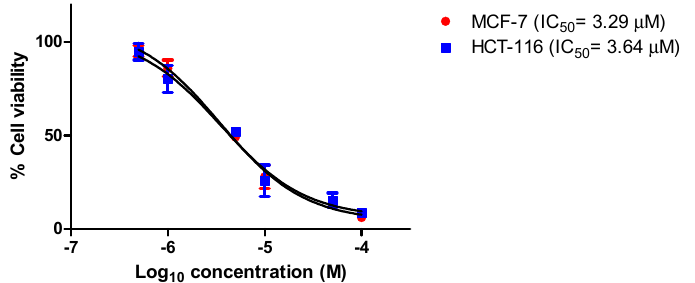
Figure 2. Anti-proliferative effect of 4b in MCF-7 and HCT-116 cells. Cells were grown in 96-well plates and treated with 4b at 0.1 µM to 100 µM 0.05–100 µM for 72 h. Cell viability was expressed as a percentage of vehicle control [ethanol 0.1% (v/v)] treated cells. The values represent the mean ± S.E.M. for three independent experiments performed in triplicate.